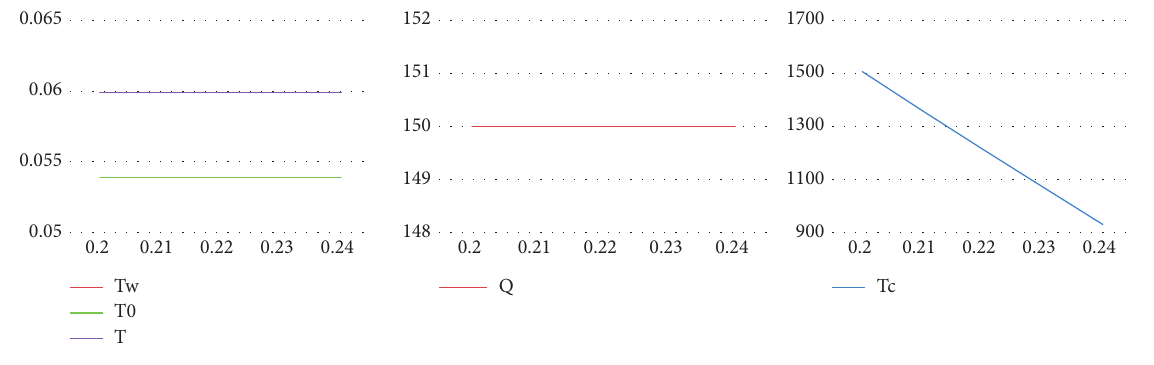
Figure 13: The effect of parameter M on decision